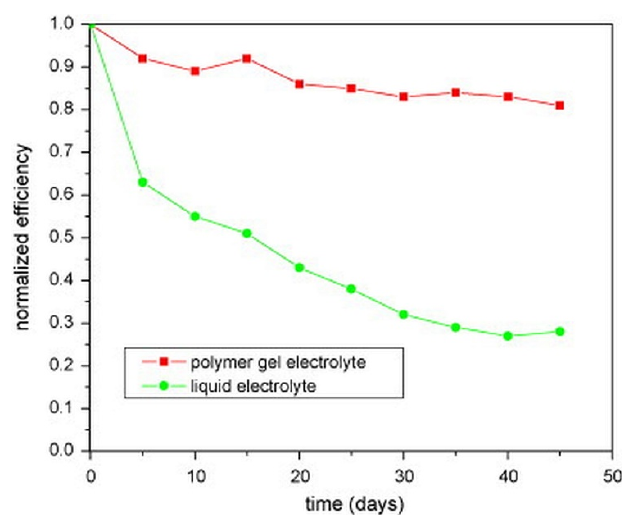
Figure 6. Long-term stability of the DSSCs with liquid electrolyte (circle) and with the gel polymer electrolyte PMMA–EC/PC/DMC–NaI/I 2 (square), adapted from reference [60]. [Reproduced with kind